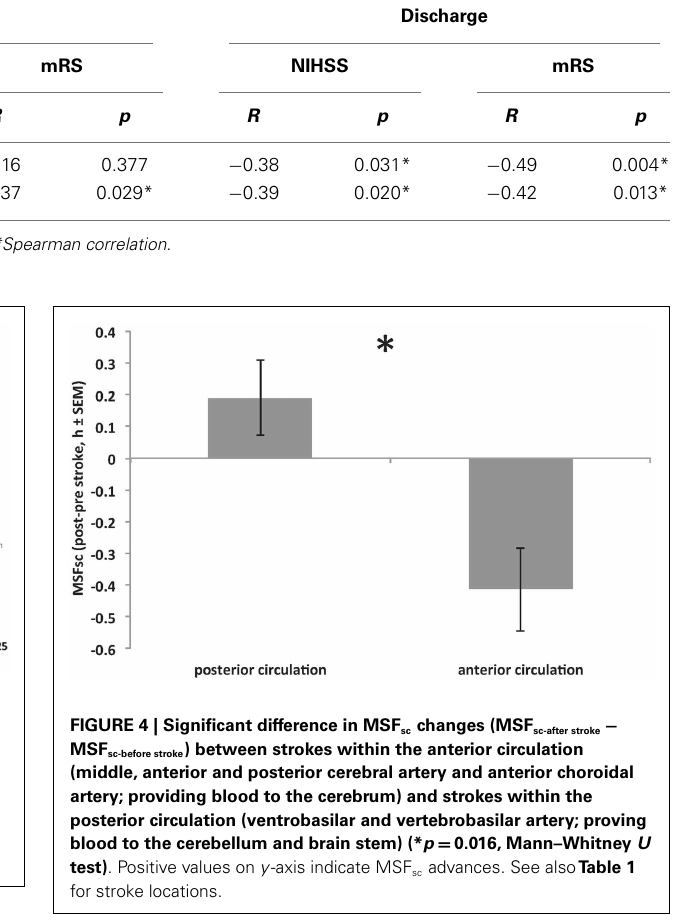
Table 4 | Significant correlations between MCTQ entries and stroke time point with NIHSS and mRS in 35 (13 female) patients . Variables